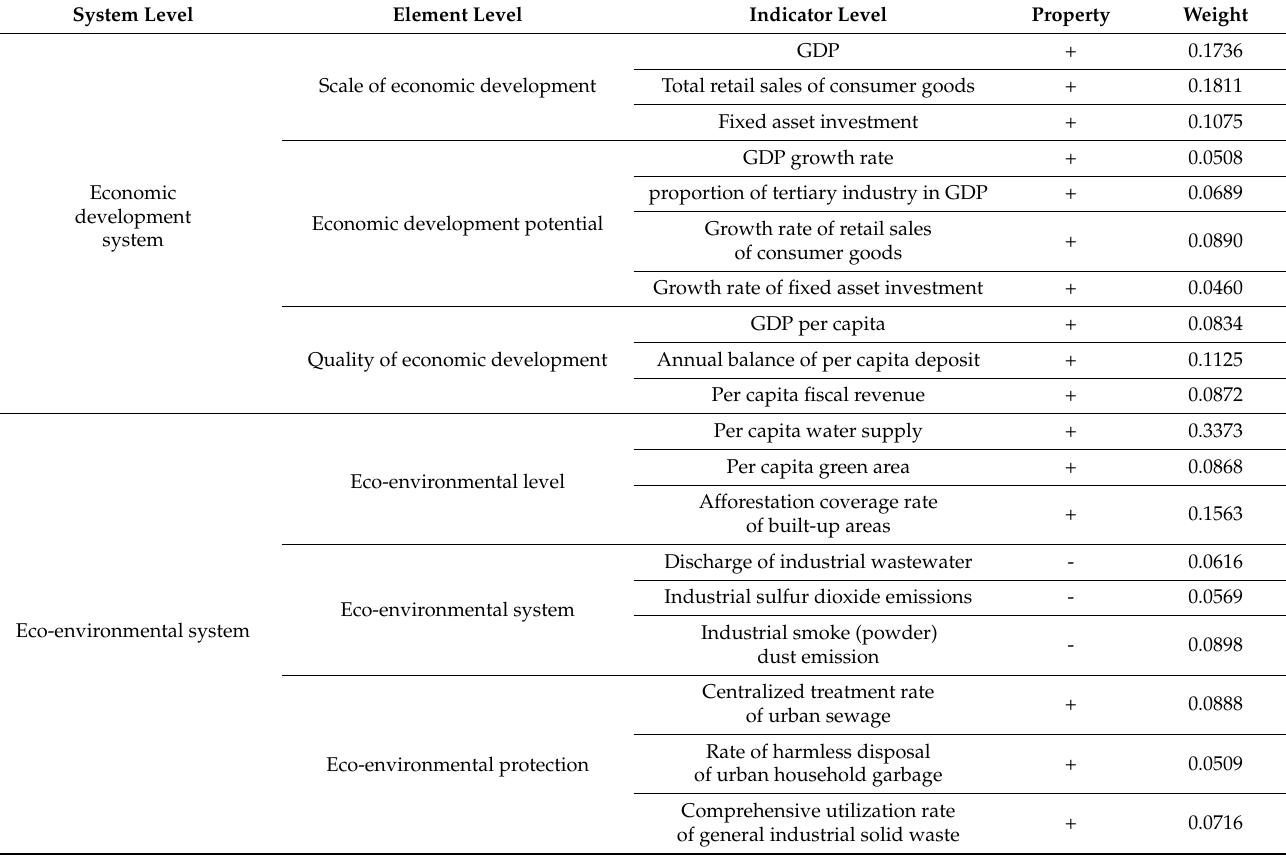
Table 1. Evaluation Index System for Coordinated Development of ED and EE in